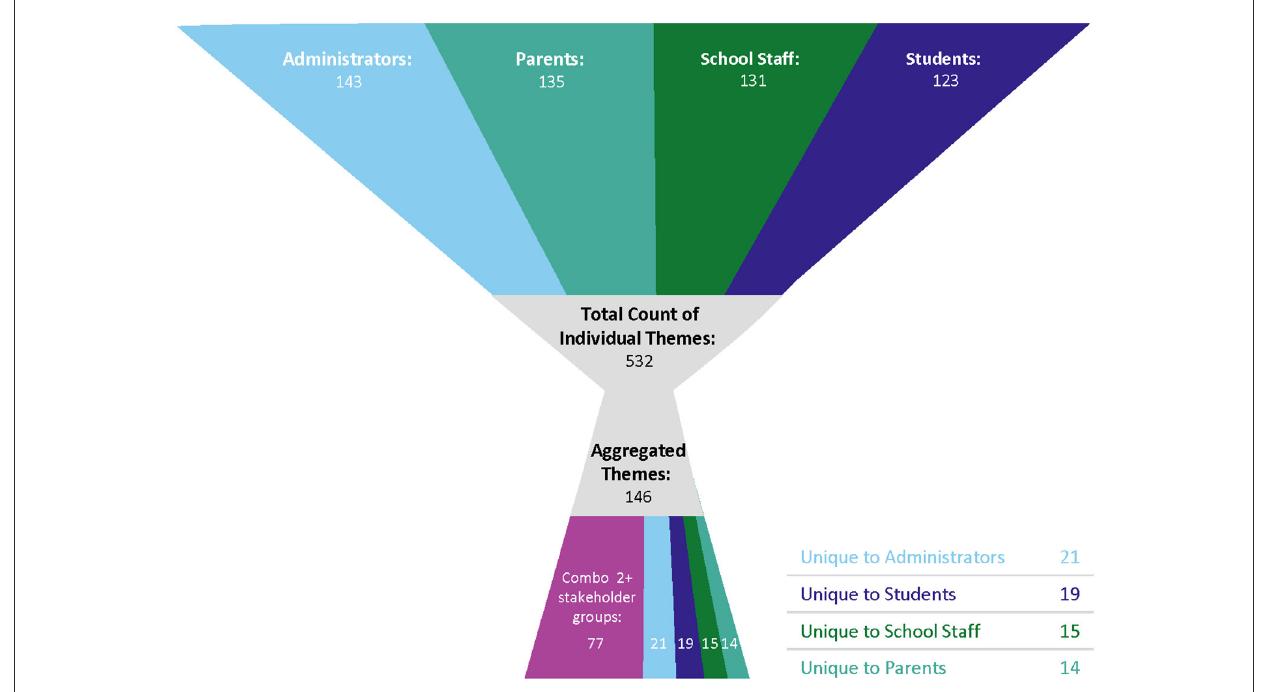
FIGURE1 Theme statement count by stakeholder